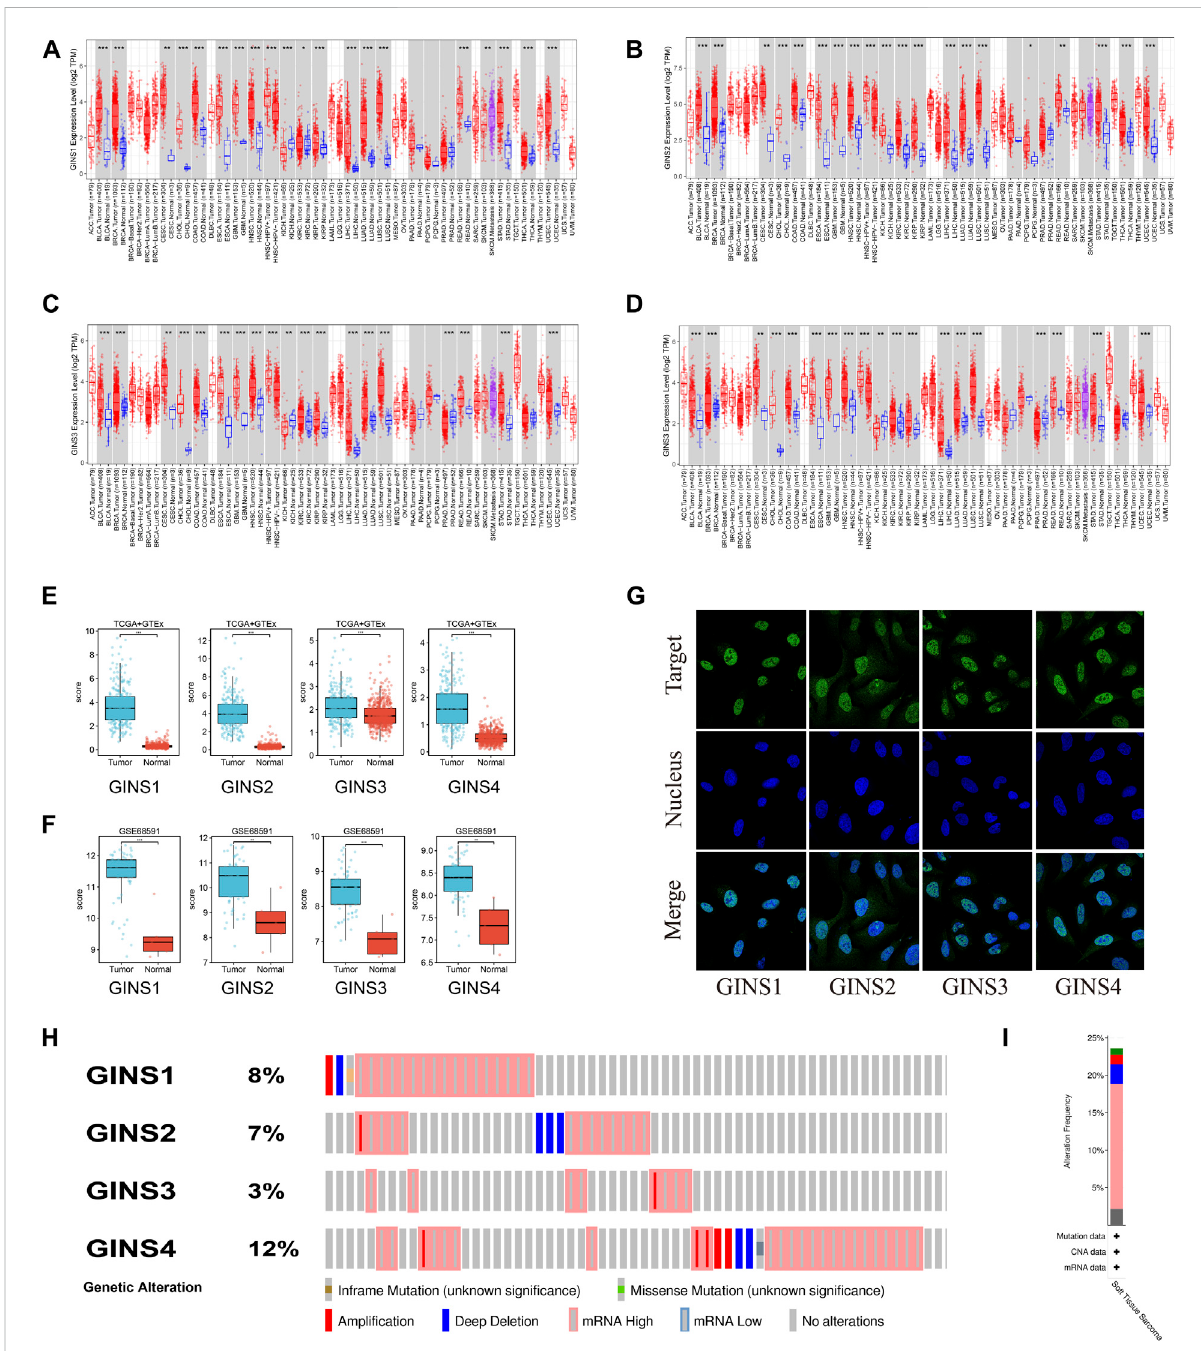
FIGURE 3 The expression alteration of GINS subunits in sarcoma. Expression levels of GINS1/2/3/4 in pan-cancer (A – D) . Expression levels of GINS1/2/3/ 4insarcomainTCGAandGTExdatabase (E) .ExpressionlevelsofGINS1/2/3/4insarcomainGSE68591dataset (F) .Theimmuno fl uorescenceimages exhibited GINS1/2/3/4 proteins (green) and nucleus (blue) co-localization in the osteosarcoma cell line (U2OS) (G) . Frequency and type of alteration of GINS1/2/3/4 in sarcoma (H – I)